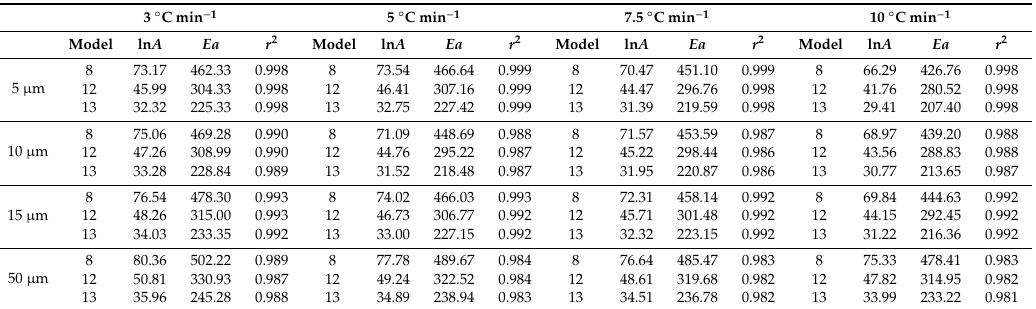
Table 3. Activation energies, pre-exponential, and corresponding linearity coe ffi cient calculated by Coats–Redfern method for the three best